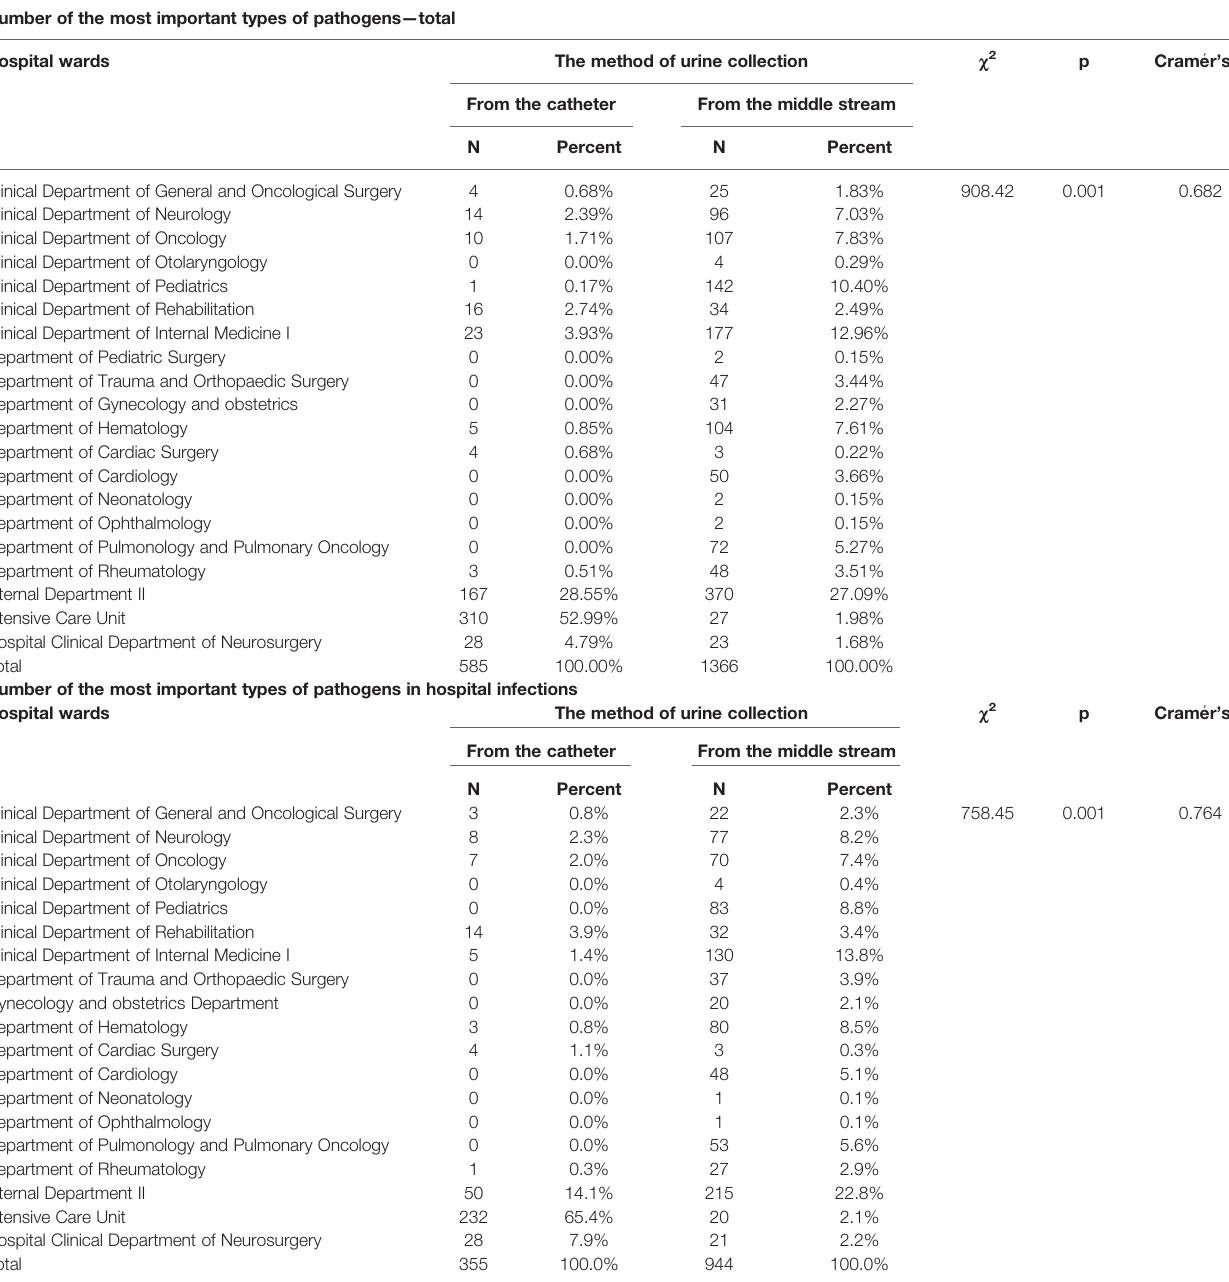
TABLE 6 | Presence of the most common types of pathogens on selected hospital wards. Number of the most important types of pathogens — total Hospital